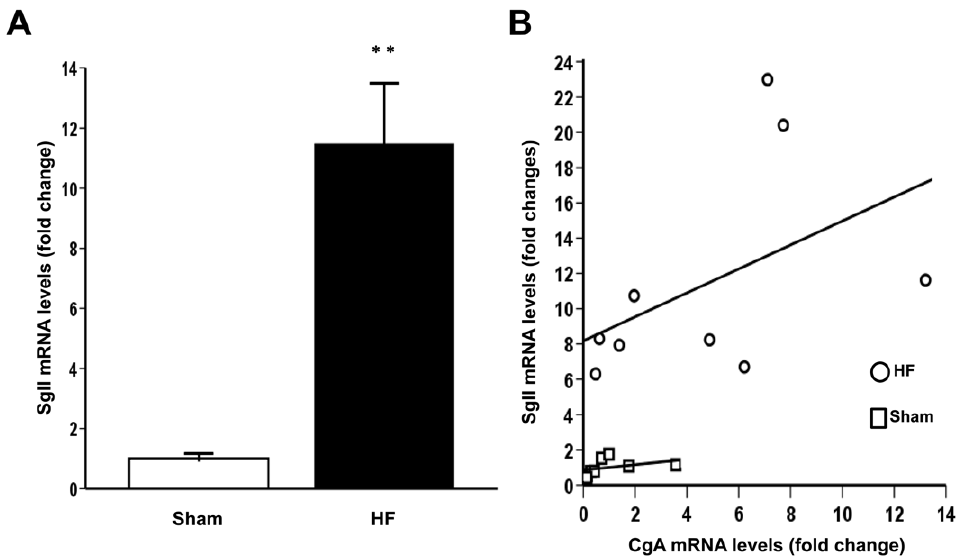
Figure 1. Left ventricular SgII gene expression in heart failure. A, SgII mRNA levels in non-infarcted left ventricular tissue during HF development. SgII mRNA levels were 10.5 fold increased (p , 0.001) in non-infarcted LV tissue in HF animals (n=9) compared to sham-operated animals (n=8). Gene expression was measured by RT-qPCR and is presented as fold change 6 SEM. B, LV SgII mRNA levels were closely correlated with CgA mRNA levels in both HF (r=0.68, p=0.04) and sham animals (r=0.81, p=0.02). **p , 0.001.